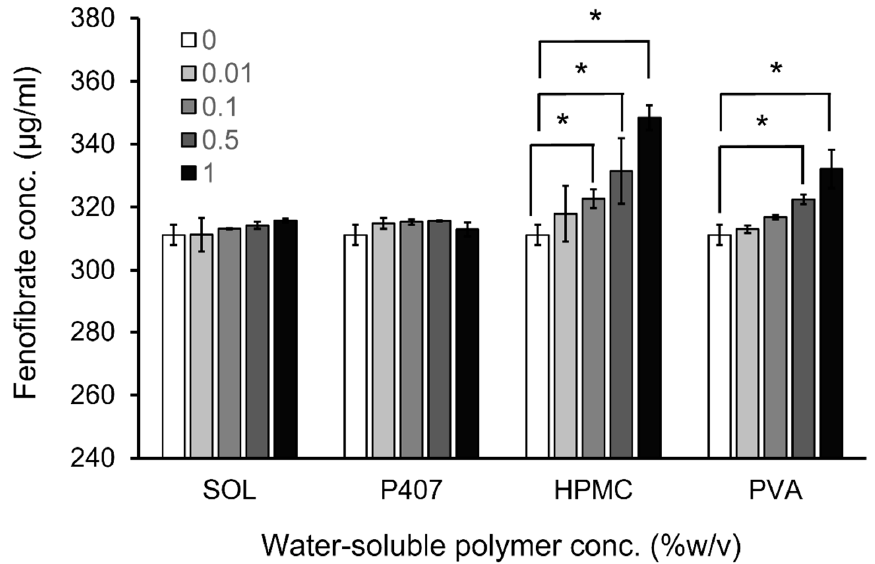
Figure 2. The solubility of fenofibrate in aqueous 5% w / v RM β CD solutions containing various concentrations of water-soluble polymers (0–1.0% w / v ). SOL, Soluplus ® ; P407, poloxomer 407; HPMC, hydroxypropyl methylcellulose; PVA, polyvinyl alcohol. * Statistical difference ( p < 0.05) when compared to that of solutions without polymers.